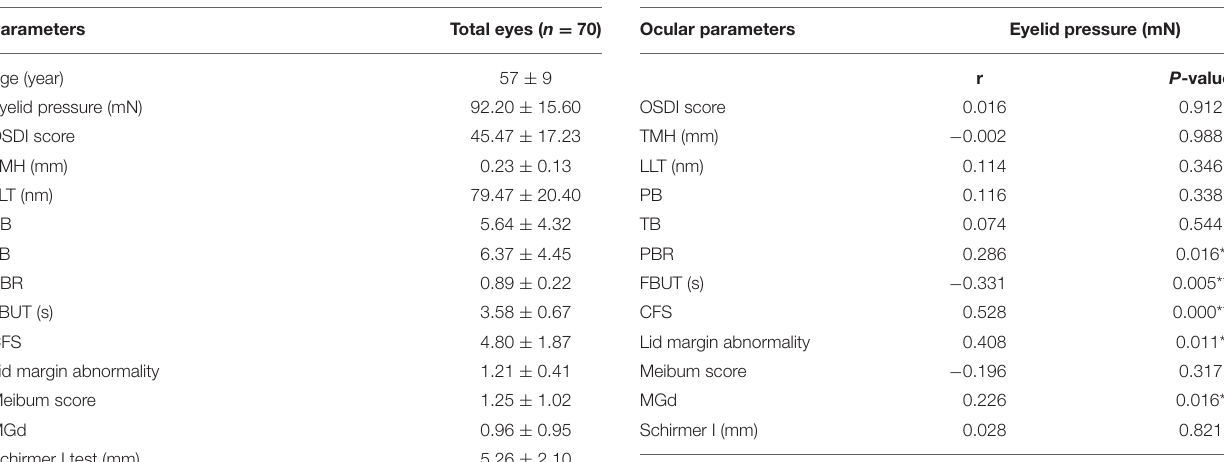
TABLE 2 | Relationship between eyelid pressure and ocular surface parameters.